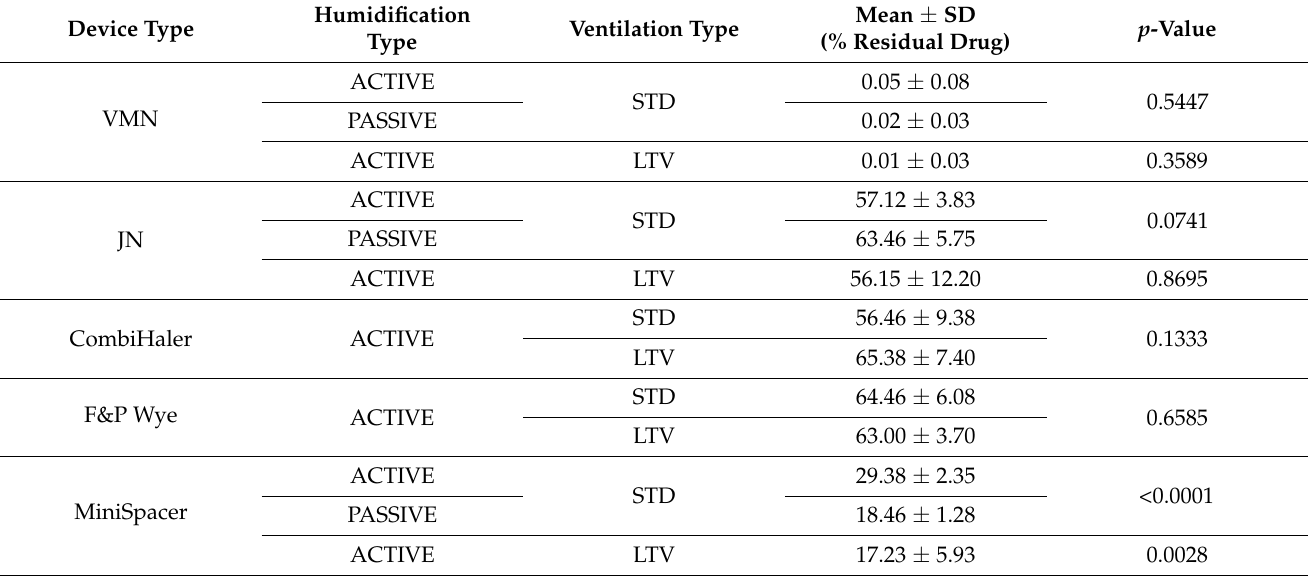
Table 3. Residual drug post nebulisation within the VMN and JN devices and the pMDI adapters during active and pas- sive humidification (STD = standard). Results are presented as mean ± SD % residual drug.